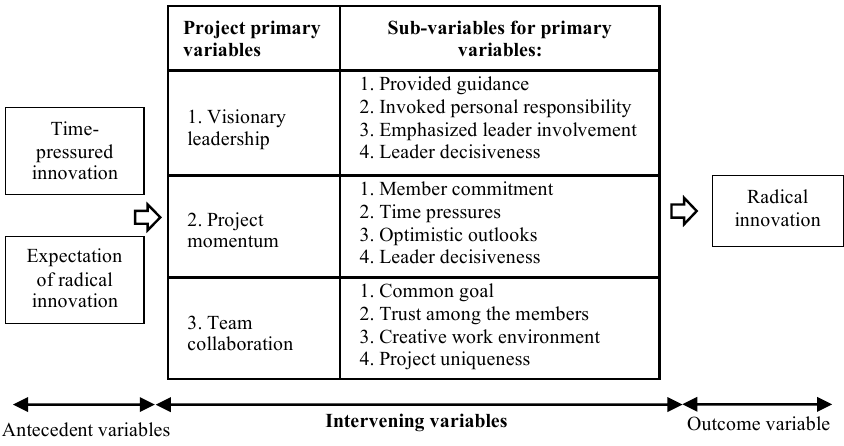
Fig. 3. Framework for time-pressured innovation in its development phase (Kach et al., 2012).